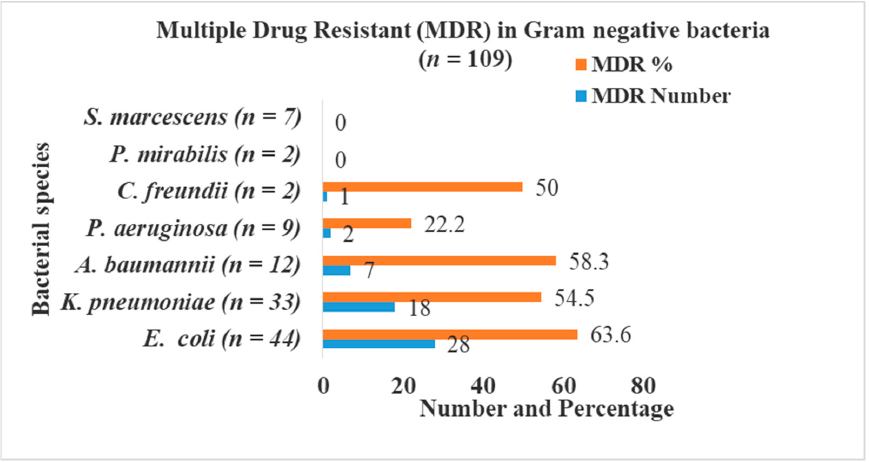
Figure 1. MDR in Gram-negative bacteria.